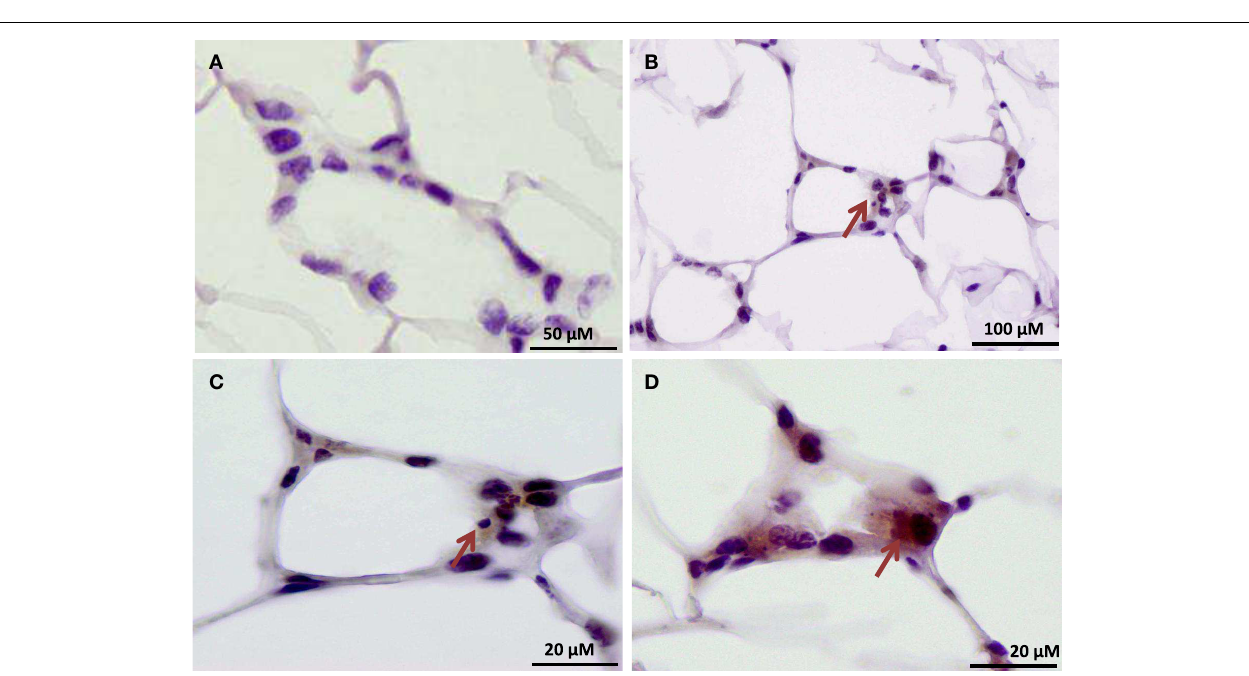
FIGURE 4 | Extracellular trap-like structures within CLS lesions of the murine mammary gland stain positive for the histone H4Cit3 modification. Immunostaining of mouse mammary gland adipose tissue with